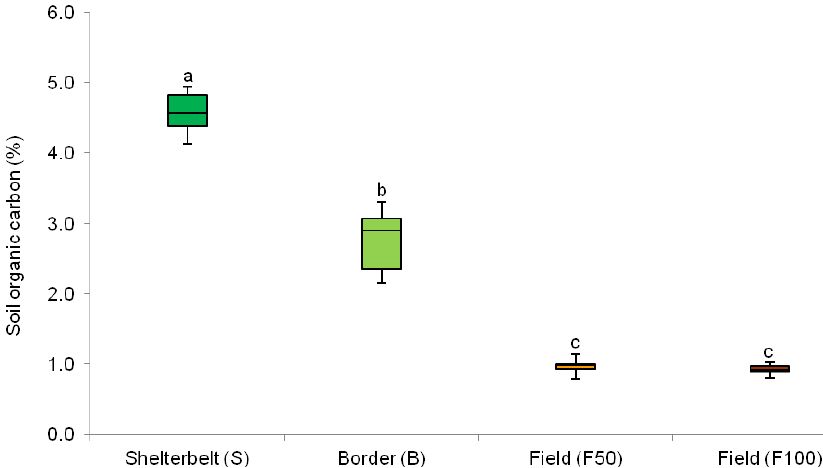
Figure 2. Box plots and results of one-way ANOVA showing the effect of soil use on soil organic carbon (SOC) content along the measurement transect. The top hanging bar represents the high edge, and the lower hanging bar is the lower edge; − median; □ quartile 25–75%; significant difference at p < 0.05; n = 9; different letters indicate significant differences.